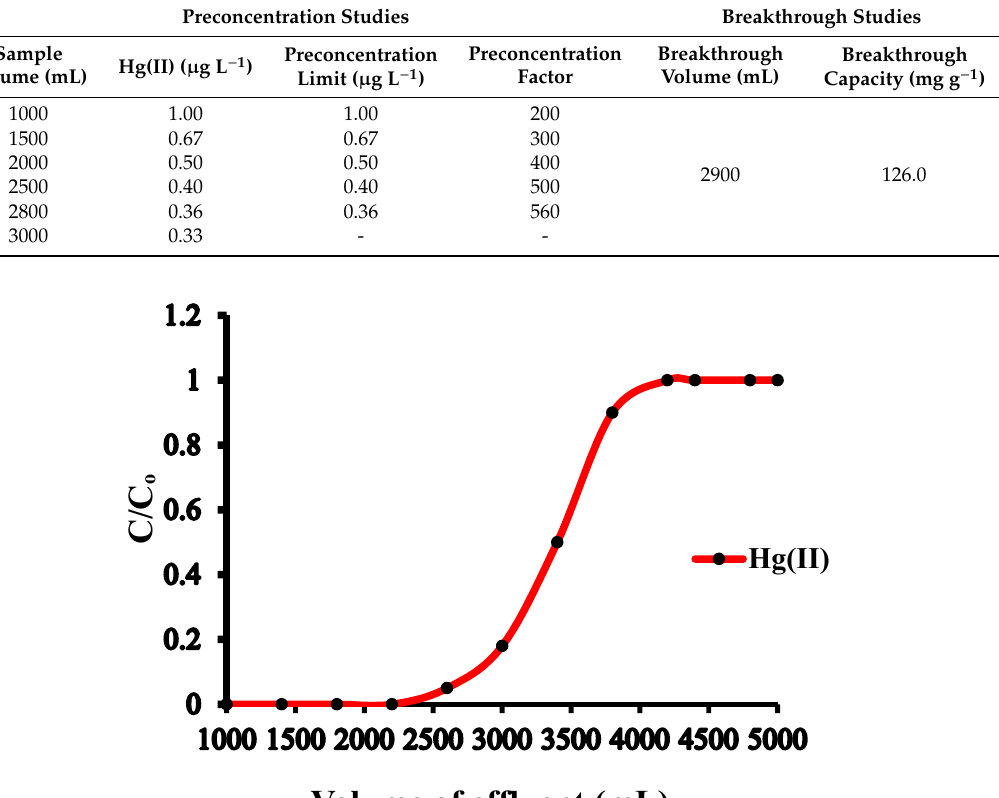
Table 2. Preconcentration and breakthrough studies using CNFs@CdS adsorbent (column parameters: